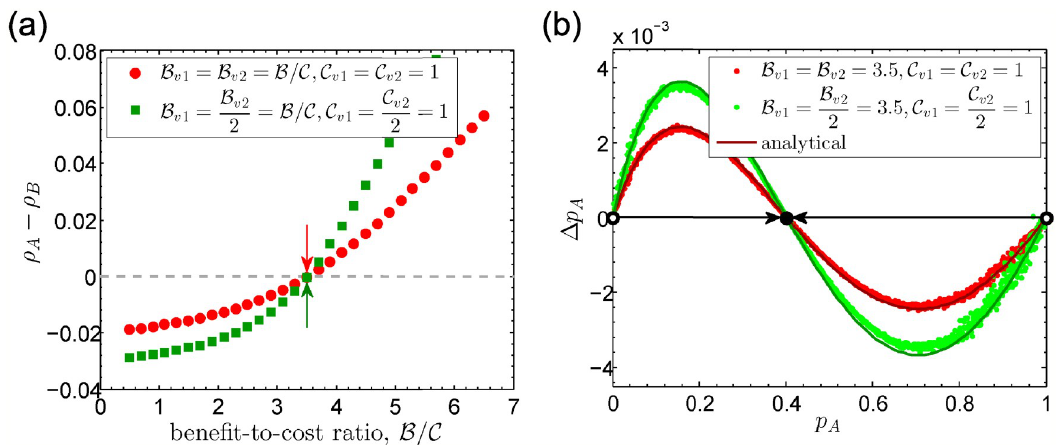
Fig 3. Evolutionary multiplayer games on weighted graphs. Each individual participates in two volunteer’s dilemmas and both group sizes are 3. Benefits and costs are B and C for one dilemma, B and C for the other. (a) Difference in fixation probability v 1 v 1 v 2 v 2 ρ A − ρ B as a function of benefit-to-cost ratio ð B = C Þ . (b) Average change ( Δ p A ) in the frequency of A − players ( p A ). Arrows in (a) mark the analytical benefit-to-cost ratio ð B = C Þ � and solid lines in (b) represent analytical change in p A . Dots represent the simulation data (see S1 File, Section 6 for simulation details). Heterogeneous weights of edges do not change the critical benefit-to-cost ratio ð B = C Þ � in the finite population (a) or the inner equilibria (black point) in the infinite population